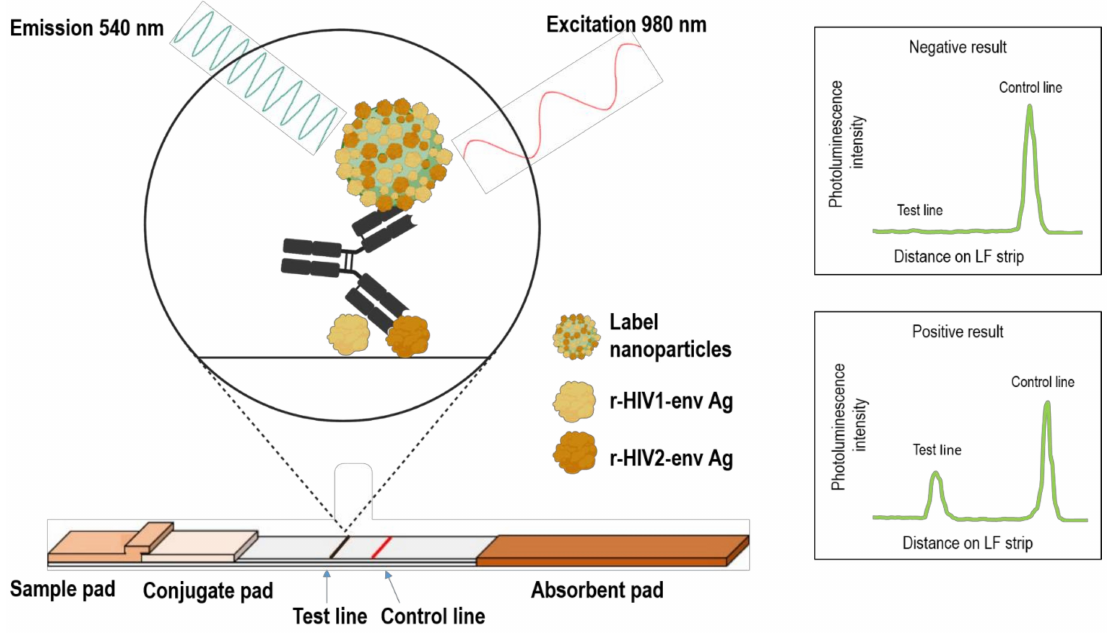
Figure 2. Anti-HIV-1/2 UCNP-LFA strip design and double-antigen bridge assay principle. Anti-HIV antibodies are detected by using recombinant HIV-1 and HIV-2 envelope antigens as captures on the test line as well as coupled to the UCNP surface. UCNPs are excited at 980 nm and the emission peak intensity at 540 nm indicates a negative or positive